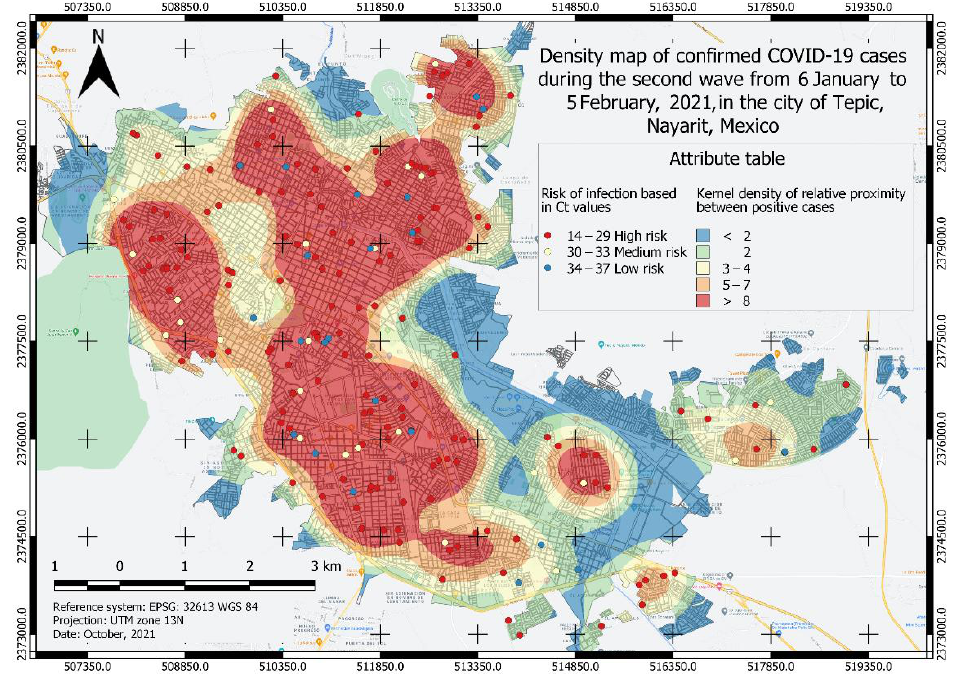
Figure 3. Density map of confirmed COVID-19 cases in the second wave from 6 January to 5 February 2021, in the city of Tepic, Nayarit, Mexico. The different areas classified by color indicate the level of risk of probability of contagion of the COVID-19 disease and each point corresponds to a confirmed case categorized by its Ct value.